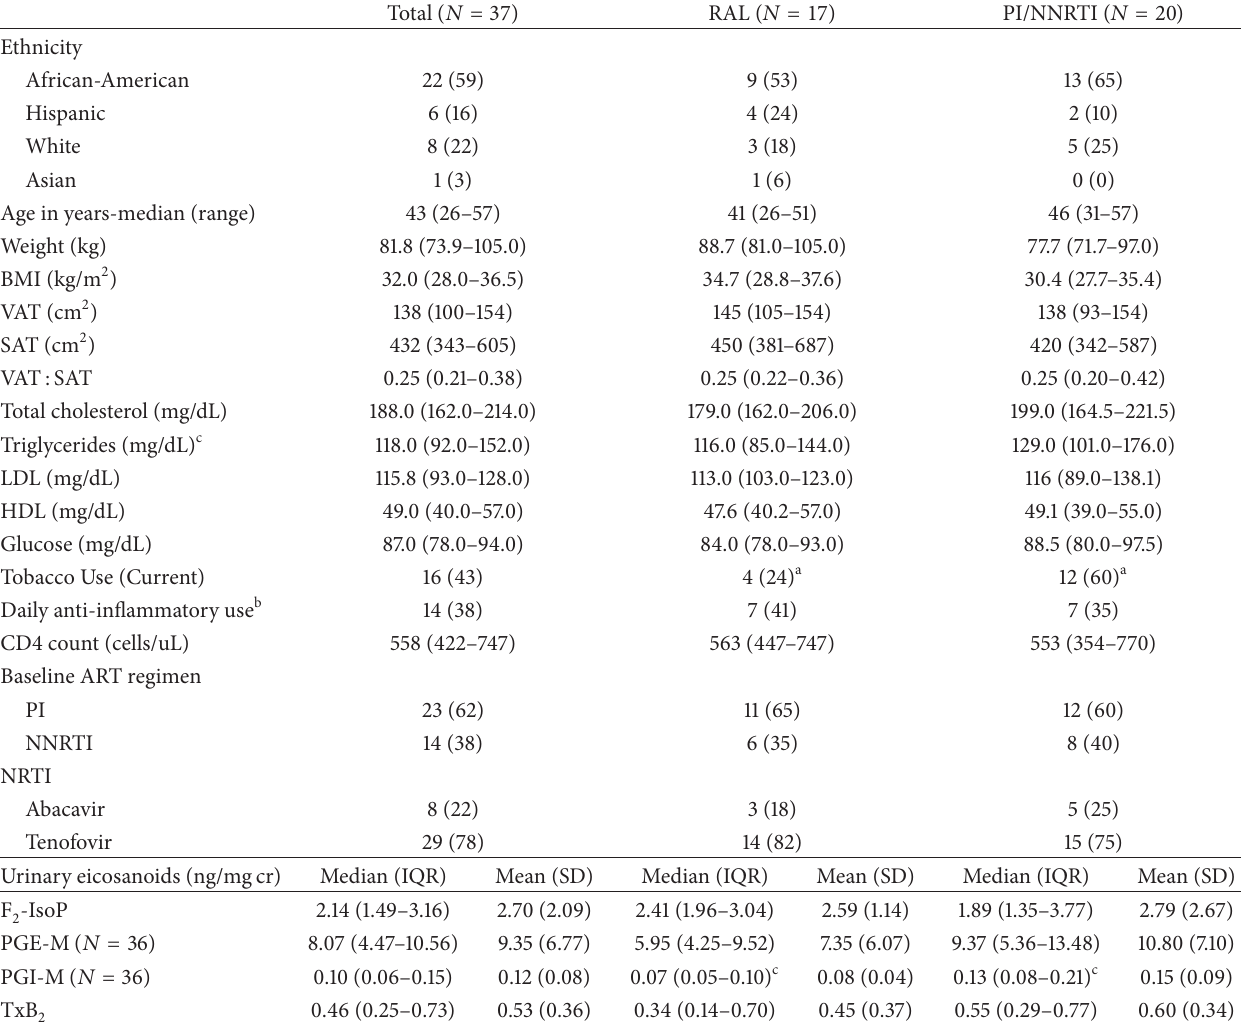
Table 1: Baseline characteristics of subjects completing 24 weeks of follow-up and included in eicosanoid analyses, total and by study